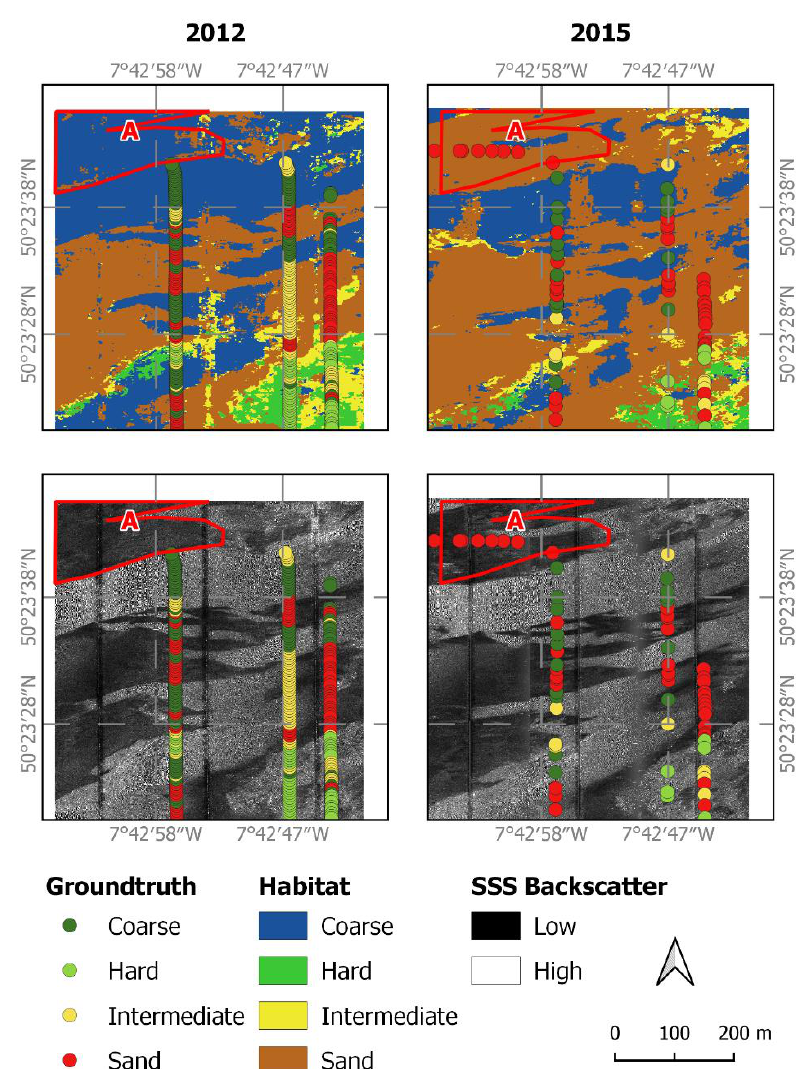
Figure 13. Example of classification changes between 2012 and 2015 at the northern end of the study area, note variation in delimited region identified as ‘A’. The difference in classification could be partly the result of a lack of groundtruthing points in the 2012 dataset. Mercator projection with standard parallel 50. WGS84 datum.